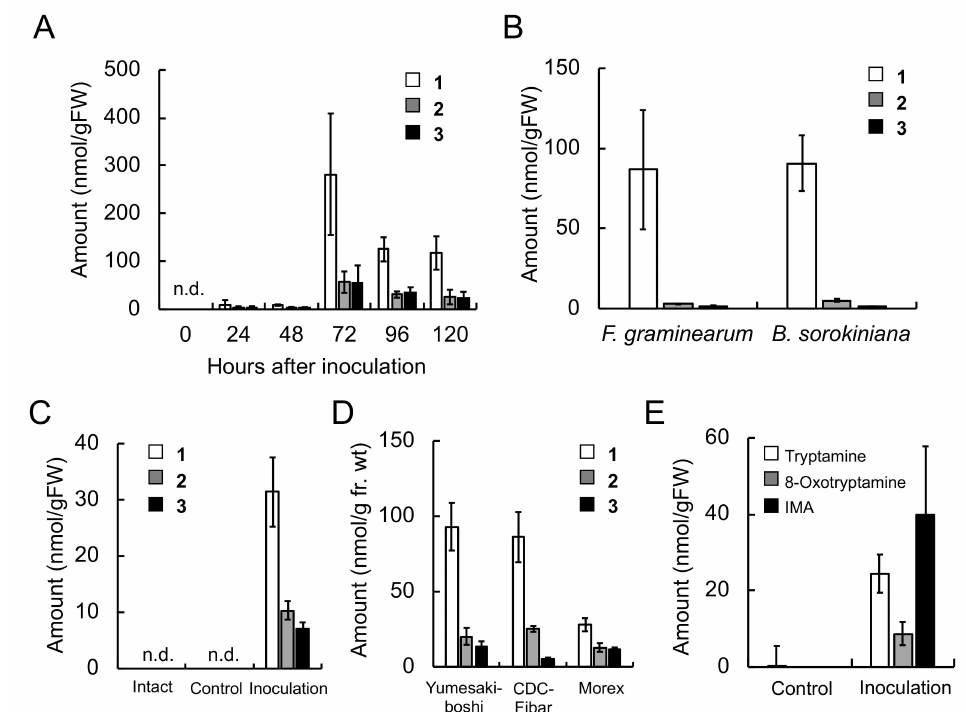
Figure 3. Accumulation of 1 – 3 and indole amines in pathogen-infected barley plants. ( A ) E ff ect of infection duration on the accumulation of 1 – 3 in Fusarium culmorum -infected roots. ( B ) Accumulation of 1 – 3 in Fusarium graminearum - and Bipolaris sorokiniana- infected roots at 72 h after inoculation. ( C ) Accumulation of 1 – 3 in B. sorokiniana -inoculated, distilled water-treated (control), and intact leaves. ( D ) Accumulation of 1 – 3 in F. culmorum -infected roots of barley cultivars ‘Yumesakiboshi’, ‘CDC Fibar’, and ‘Morex’ at 72 h after inoculation. ( E ) Accumulation of tryptamine, 8-oxotryptamine, and (1 H -indol-3-yl)methylamine (IMA) in F. culmorum -infected roots at 72 h after inoculation. Values and error bars represent mean ± SD ( n = 3). n.d., not